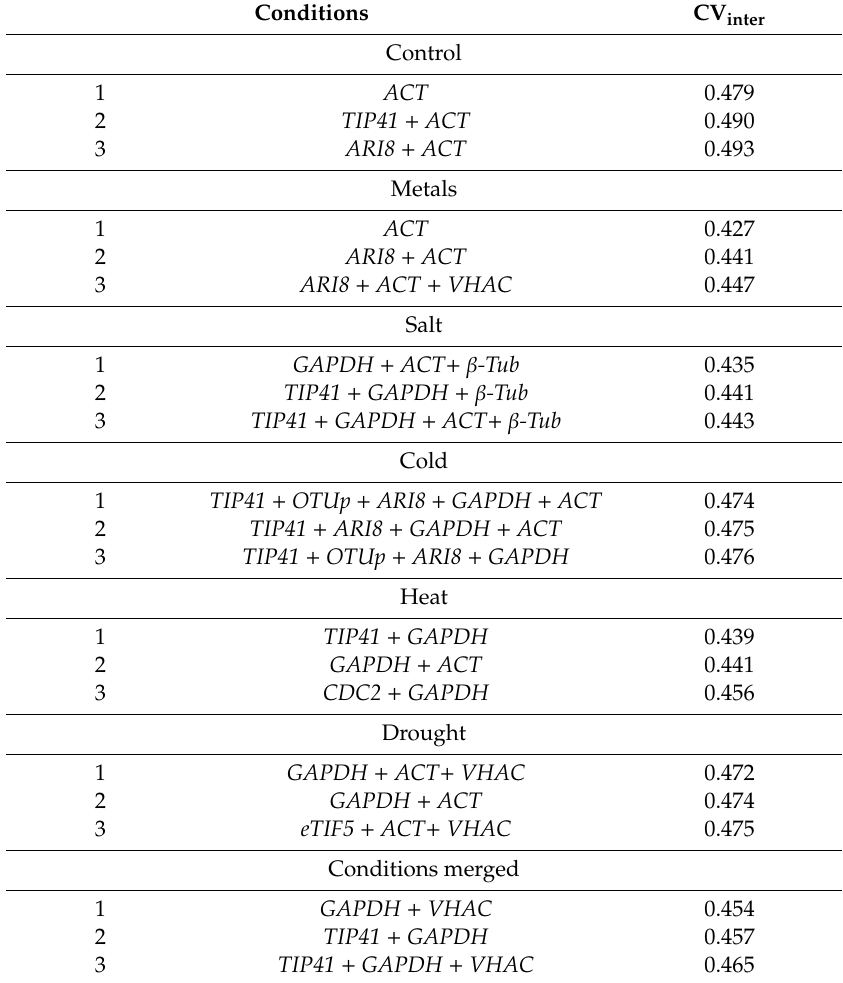
Table 8. Optimal combinations of reference genes to use for appropriate data normalization in S. viminalis roots under abiotic stress conditions as computed by